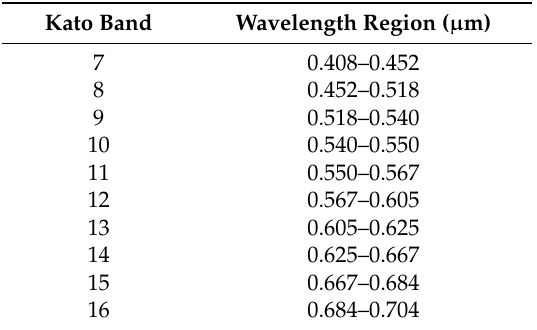
Table 1. Kato bands in the photosynthetically active radiation (PAR)